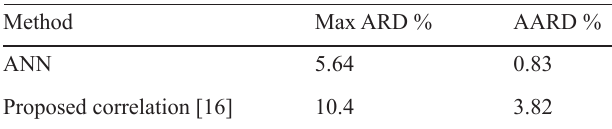
Table 2. Statistical criteria of the proposed ANN.